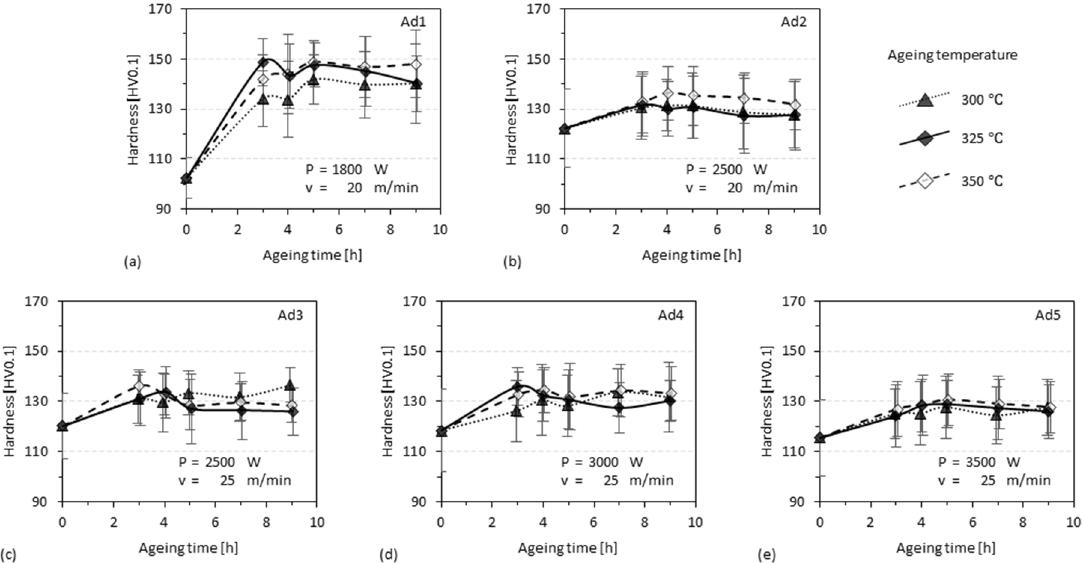
Figure 13. Microhardness profiles over ageing time of the specimens sampled from ( a ) Ad1, ( b ) Ad2, ( c ) Ad3, ( d ) Ad4, and ( e ) Ad5. The aging time 0 h stands for the as-built state. P : laser power [W], v : travel speed [m/min]. Every value corresponds to the mean value of 30 indentations. Error bar: 1 σ .